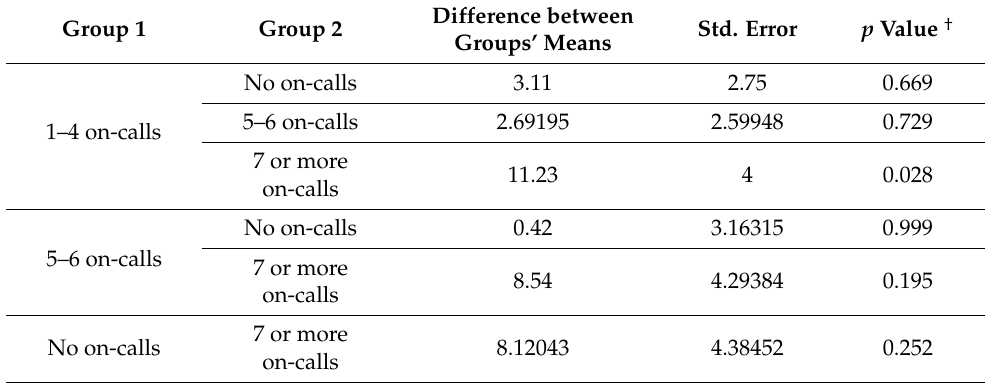
Table A4. Post hoc analysis of differences in mean JSE score by number of